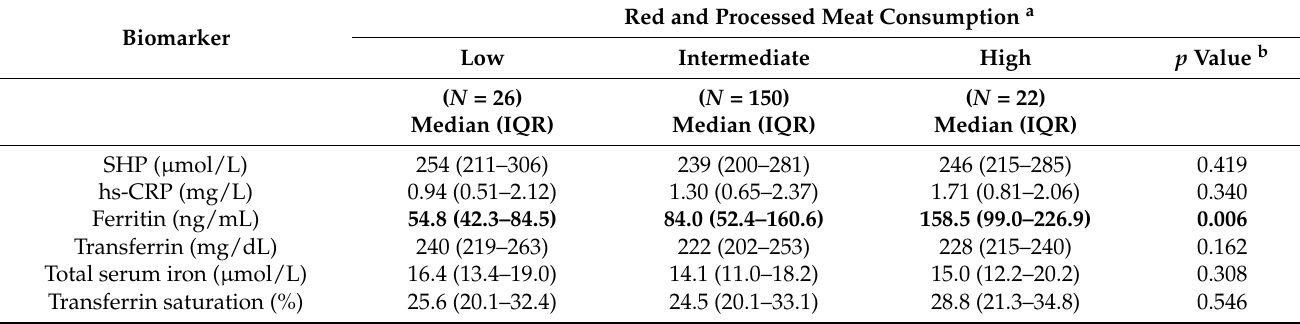
Table 2. Differences in median concentrations of biomarkers of oxidative stress, inflammation and body-iron stores according to red and processed meat consumption.